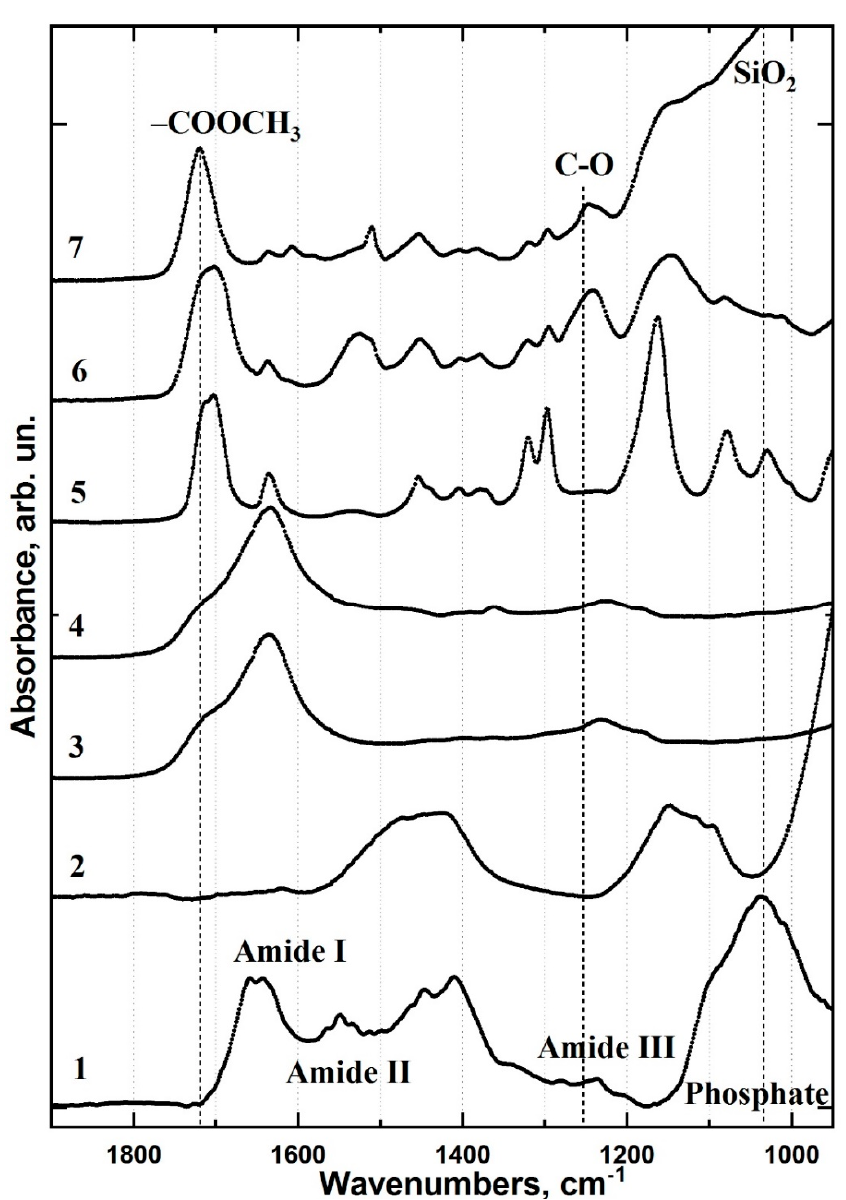
Figure 2. FTIR spectra of healthy dentine and the interface materials used for the type I and type II specimens: (1) healthy dentine; (2) Trioxident solution; (3) dentine conditioner; (4) modified dentine conditioner; (5) bioprimer; (6) Bis-GMA-based commercial adhesive; (7) Dyract XP light-curing dental compomer.